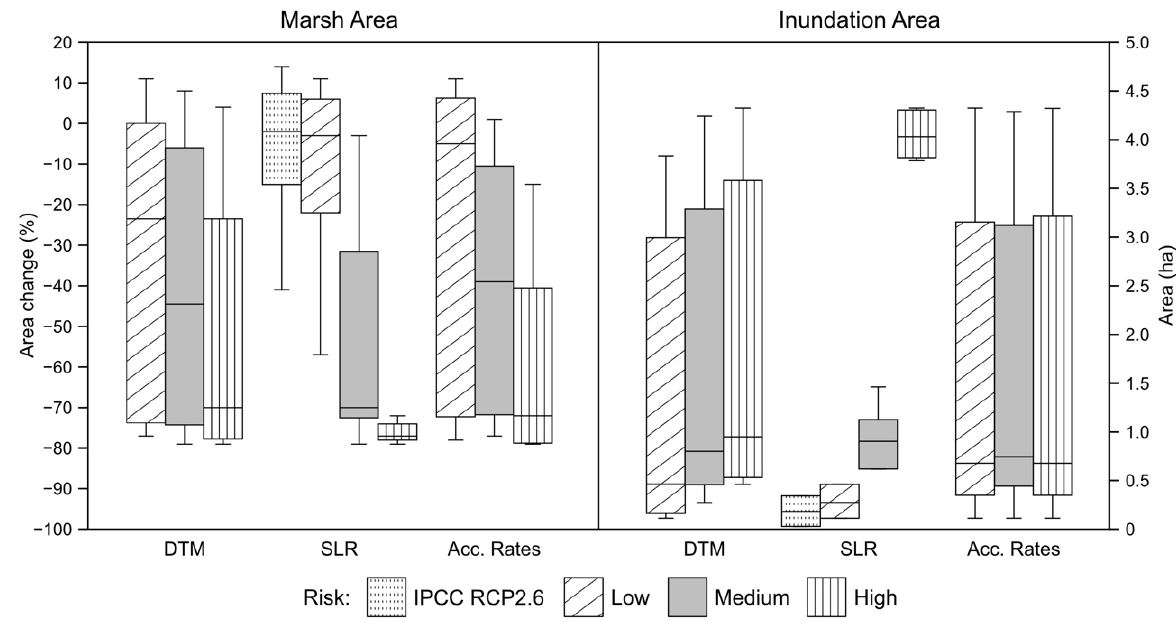
Figure 10. Boxplots of the sensitivity analysis performed on SMRM. The analysis includes three levels of risk for each evaluated parameter (DTM, SLR, and accretion rates—Acc. Rates). The analyzed results are the marsh area and the inundation area in 2100.